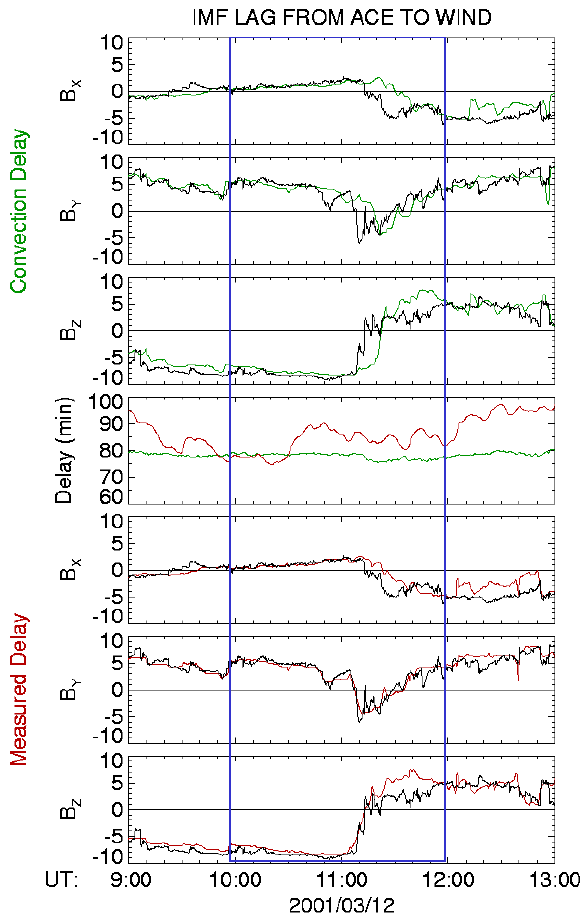
Fig. 3. Comparison of IMF data from ACE and Wind for 12 March 2001. (a)–(c) The comparison is made using the advection time (plotted in the green trace in panel (d) . (e)–(g) The comparison is made using the variable lag time, calculated using the technique of Weimer et al. (2002) and shown by the red trace in panel (d). The region of particular interest is highlighted by the blue box. Note that the lag time is increasing prior to 10:40UT, then levels off, and later decreases as the directional discontinuity is approached near 11:00UT.